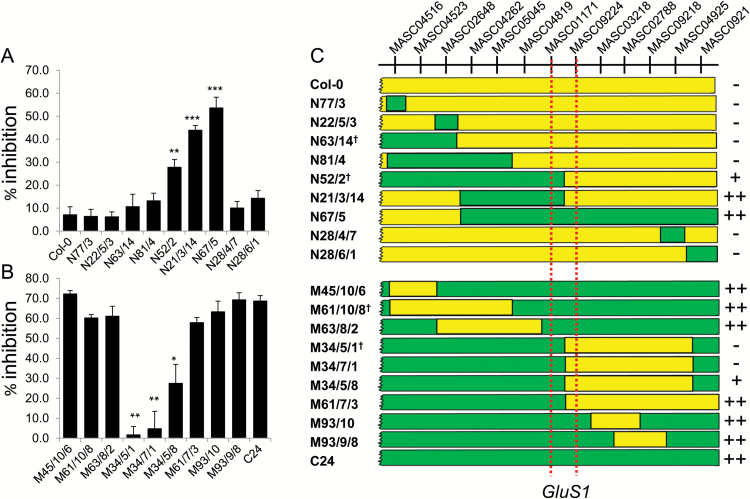
Use of introgression lines to identify the region of chromosome 3 carrying a major QTL for Glu sensitivity. Eighteen ILs, nine with a Col-0 background and nine with a C24 background, together with the Col-0 and C24 parental lines, were germinated and 4 d-old seedlings transferred to plates with and without 50 µM K glutamate. The increase in PR length over the following 5 d was measured and Glu sensitivity for each line expressed as percentage inhibition compared to controls. (A) Col-0 and nine Col-0 ILs with introgressions from C24 in chromosome 3 and (B) C24 and nine C24 ILs with introgressions from Col-0 in chromosome 3. Asterisks indicate those ILs where the Glu sensitivity differed significantly from the respective parental line based on a Student’s t test (** = P < 0.01; *** = P < 0.001; n = 9 ± SE); (C) Schematic showing the locations of introgressions in the eighteen ILs. Green, C24; yellow, Col-0. Note that only the bottom end of chromosome 3 is depicted. ILs indicated with a dagger have introgressions that are not fully represented in this schematic: in N63/14 the introgression from C24 extends to MASC03898 at the top of chromosome 3; in N52/2 the introgression from C24 extends upwards on chromosome 3 to MASC04279; M61/10/8 carries an additional introgression from Col-0 on chromosome 5 from MASC03559 to MASC01361 and M34/5/1 carries an additional introgression from Col-0 on chromosome 1 from MASC03658 to MASC02998 (Supplementary Table S4). Plus signs down the right hand side indicate ILs showing Glu hypersensitivity. The red dashed lines indicate the deduced extremities of the region carrying the GluS1 locus whose C24 allele confers Glu hypersensitivity.